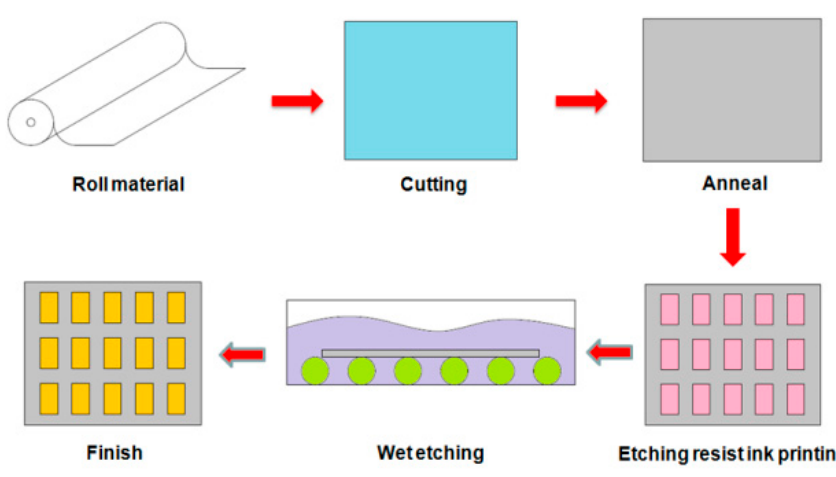
Figure 4. Manufacture processes of patterned ITO/PET film.